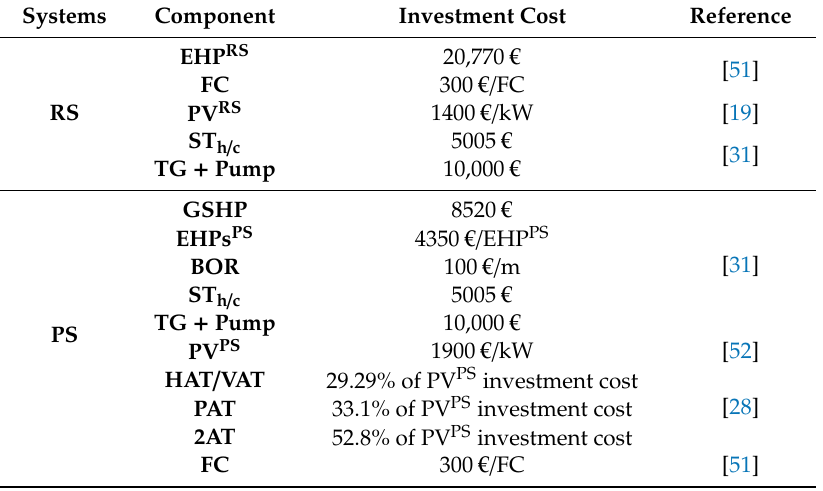
Table 7. Components investment cost of RS and PS and the corresponding